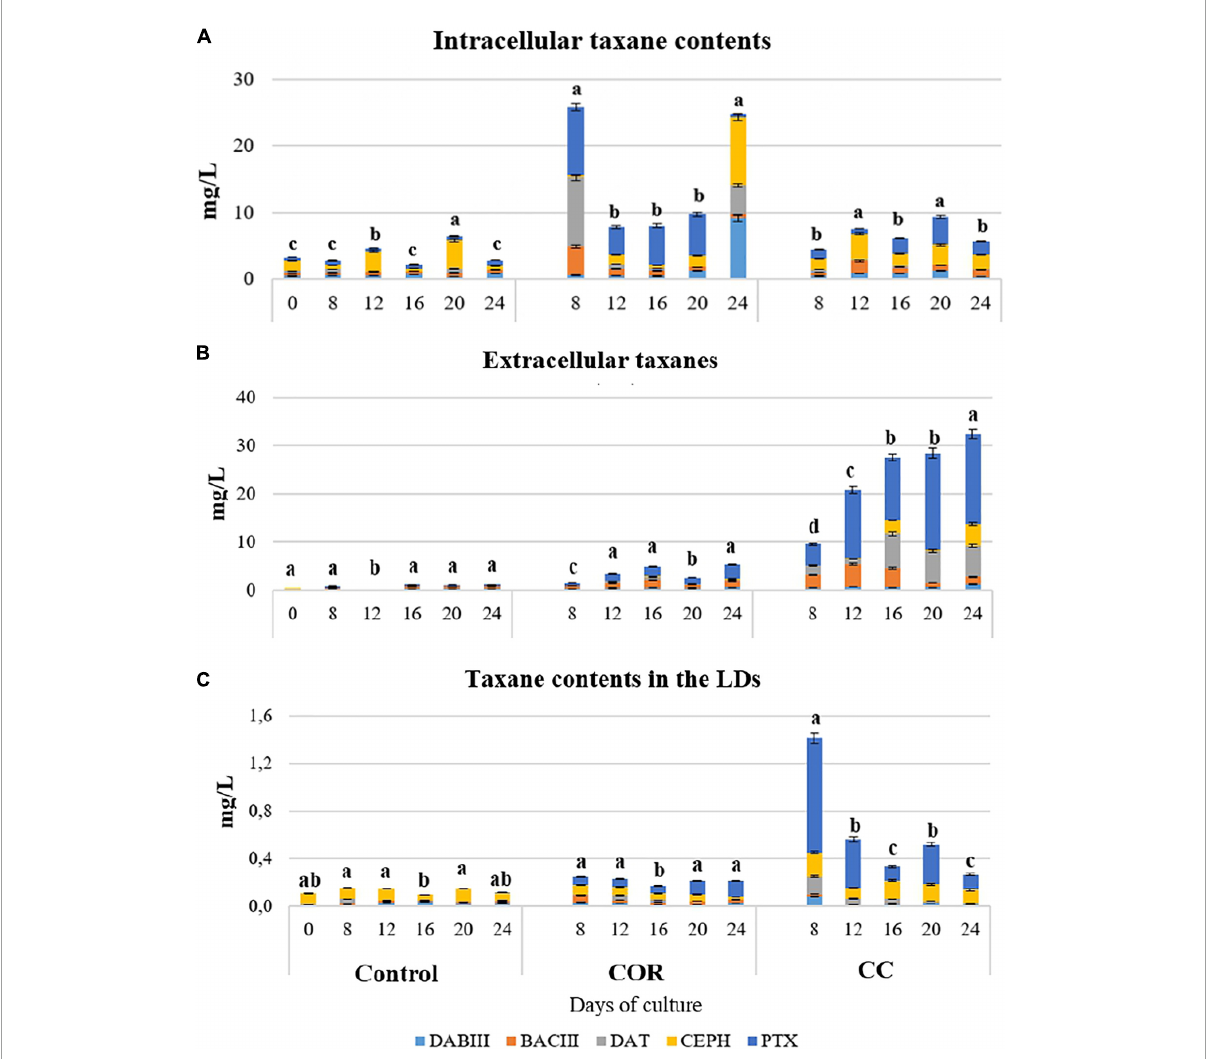
FIGURE7 Taxane content (expressed as mg L − 1 ) found inside the cells (A) , in the culture medium (B) and within the LDs (C) of T. baccata cell cultures when maintained for 24 days in the optimum medium for production complemented or not with elicitors. COR: 1 mM coronatine; CC: 1 mM coronatine + 50 mM β -CDs; DABIII: 10-deacetylbaccatin III; BACIII: baccatin III; DAT: 10deacetylpaclitaxel; CEPH: cephalomannine; PTX: paclitaxel. Values presented are means ± SD ( n = 3). Values followed by different letters are significantly different ( P ≤ 0.05) according to Tukey’s honestly significant difference